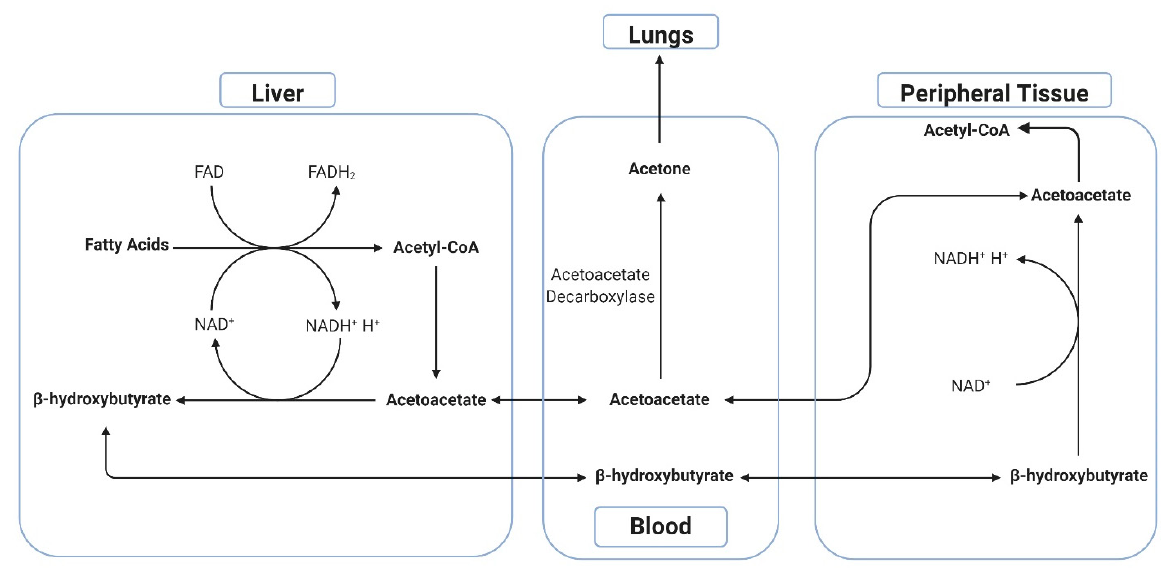
Figure 1. Human ketone metabolic pathways summary.